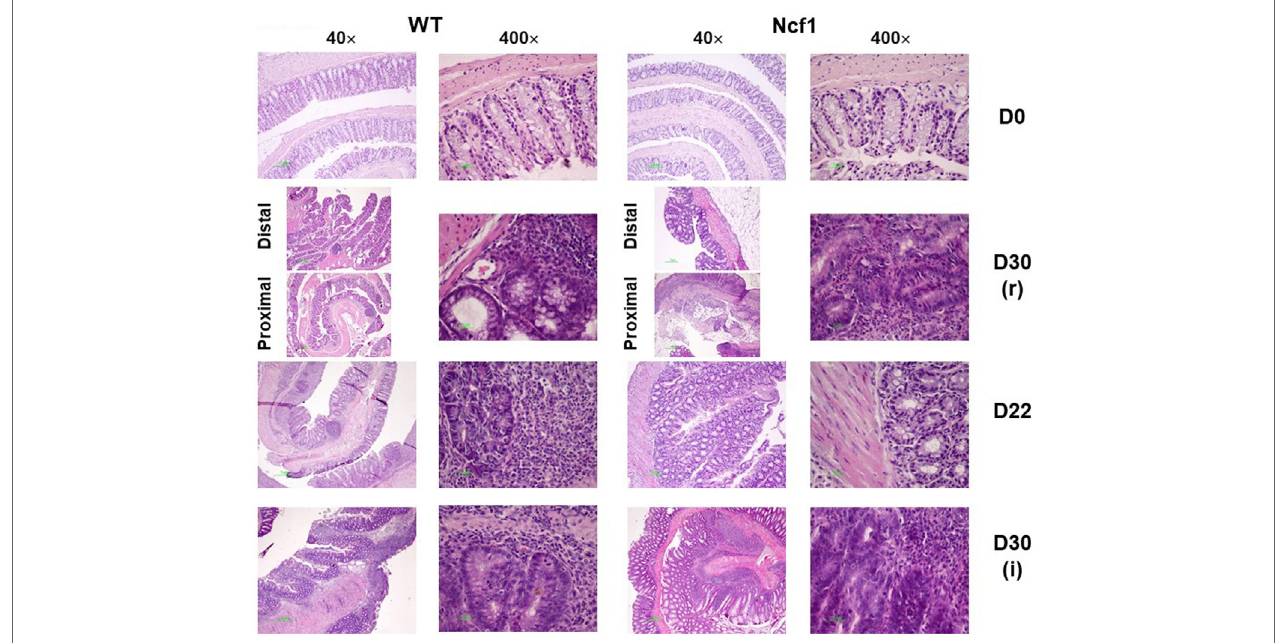
FigUre 2 | Colonic mucosa of control, recovery (r), and twice colitis-induced (i) wild-type (WT) and Ncf1-mutant (Ncf1) groups. Day 0 : glands are smaller, fewer, and with small epithelial cell nuclei in Ncf1 mice colon compared with WT mice. Day 30 of recovery : WT mouse colon with basal small gland hyperplasia and villous epithelial adaptation; Ncf1 mouse colon with superficial villous adaptation, high-grade dysplasia, and intramucosal adenocarcinoma. Day 22 for both experiments : both WT and Ncf1 mice colons with superficial villous glandular hyperplasia, and inflammation-reactive atypia in WT mouse colon; low-grade dysplasia; and mucinous cells hyperplasia in tubular glands of WT mouse colon contrasting to basal high-grade dysplasia in Ncf1 mouse colon. Day 30 of the second colitis induction : Superficial villous mucosae and basal cell glandular persistence with high-grade dysplasia in WT mouse colon compared with the superficial villous atrophy and well-differentiated adenocarcinoma in Ncf1 mouse colon. hematoxylin/eosin staining with 40 × and 400 ×